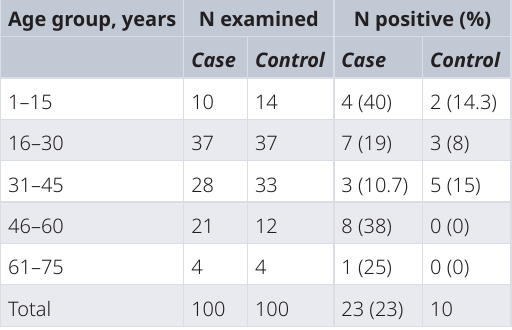
Table 2. Occurrence of gastrointestinal parasites among H. pylori patients and control individuals according age group.